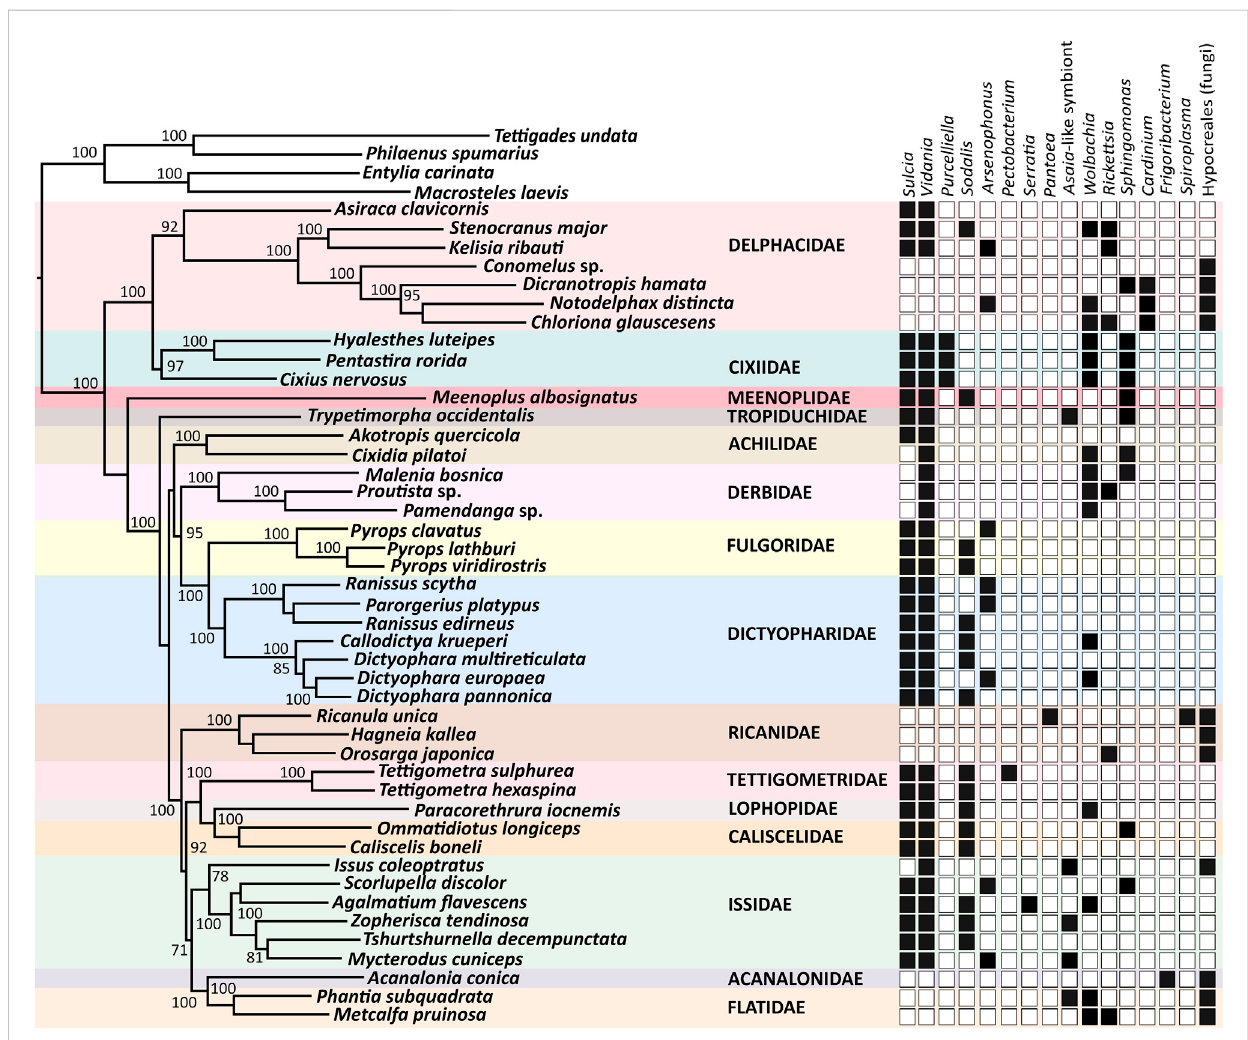
Symbiont diversity across planthopper phylogeny. The Maximum Likelihood phylogeny is constructed based on concatenated 13 mitochondrial protein-coding genes and one mitochondrial ribosomal RNA, ofatotal size of 11,713 bp.Bootstrap support values > 70% are shown. The heatmap shows the presence/absence of planthopper symbiont genera based on the sequences of 16S rDNA genes reconstructed from metagenomic